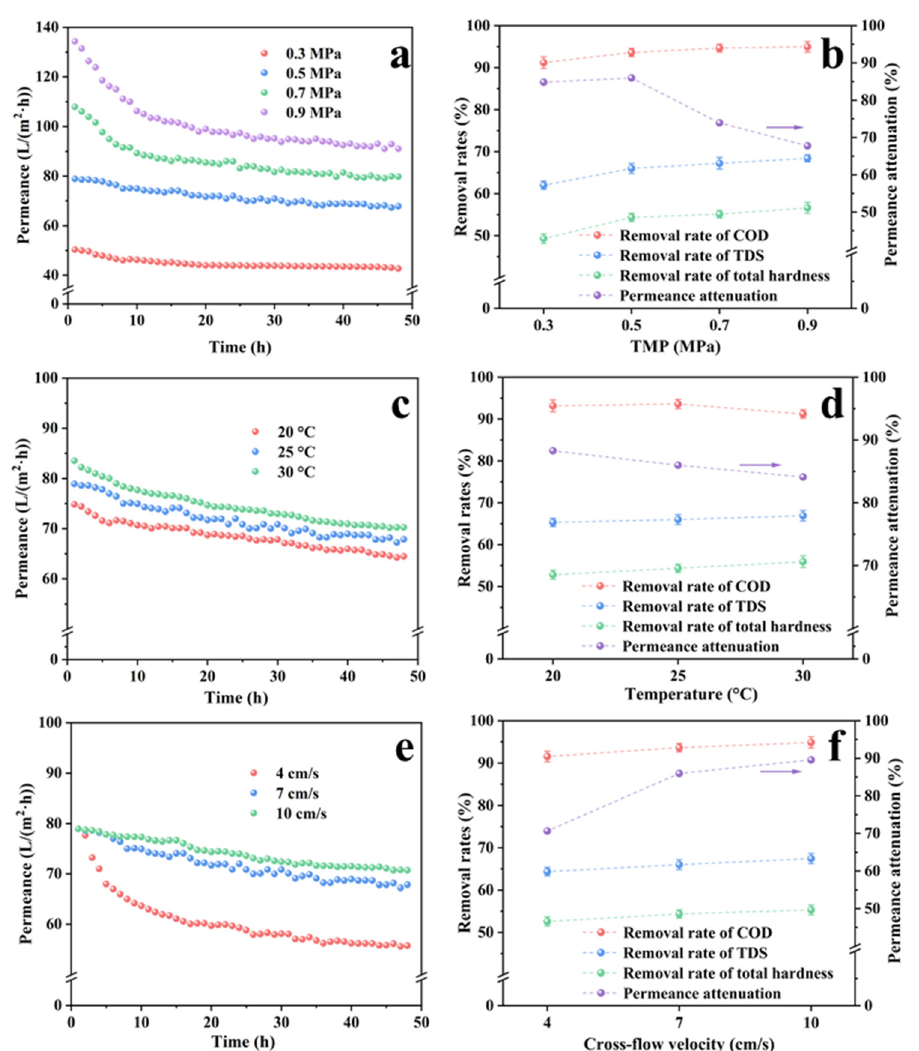
Figure 4. Influence of operating conditions on membrane permeance and nanofiltration perfor- mance of MPCM2: ( a , b ) TMP; ( c , d ) temperature; and ( e , f ) crossflow velocity. of MPCM2: ( a , b ) TMP; ( c , d ) temperature; and ( e , f ) crossflow